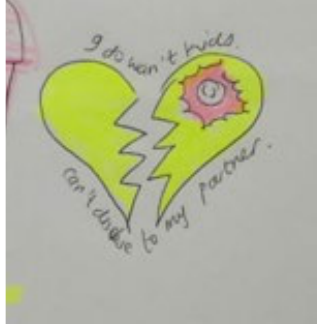
Figure 11: Romantic partnerships Figure 12: Pills, food, and school